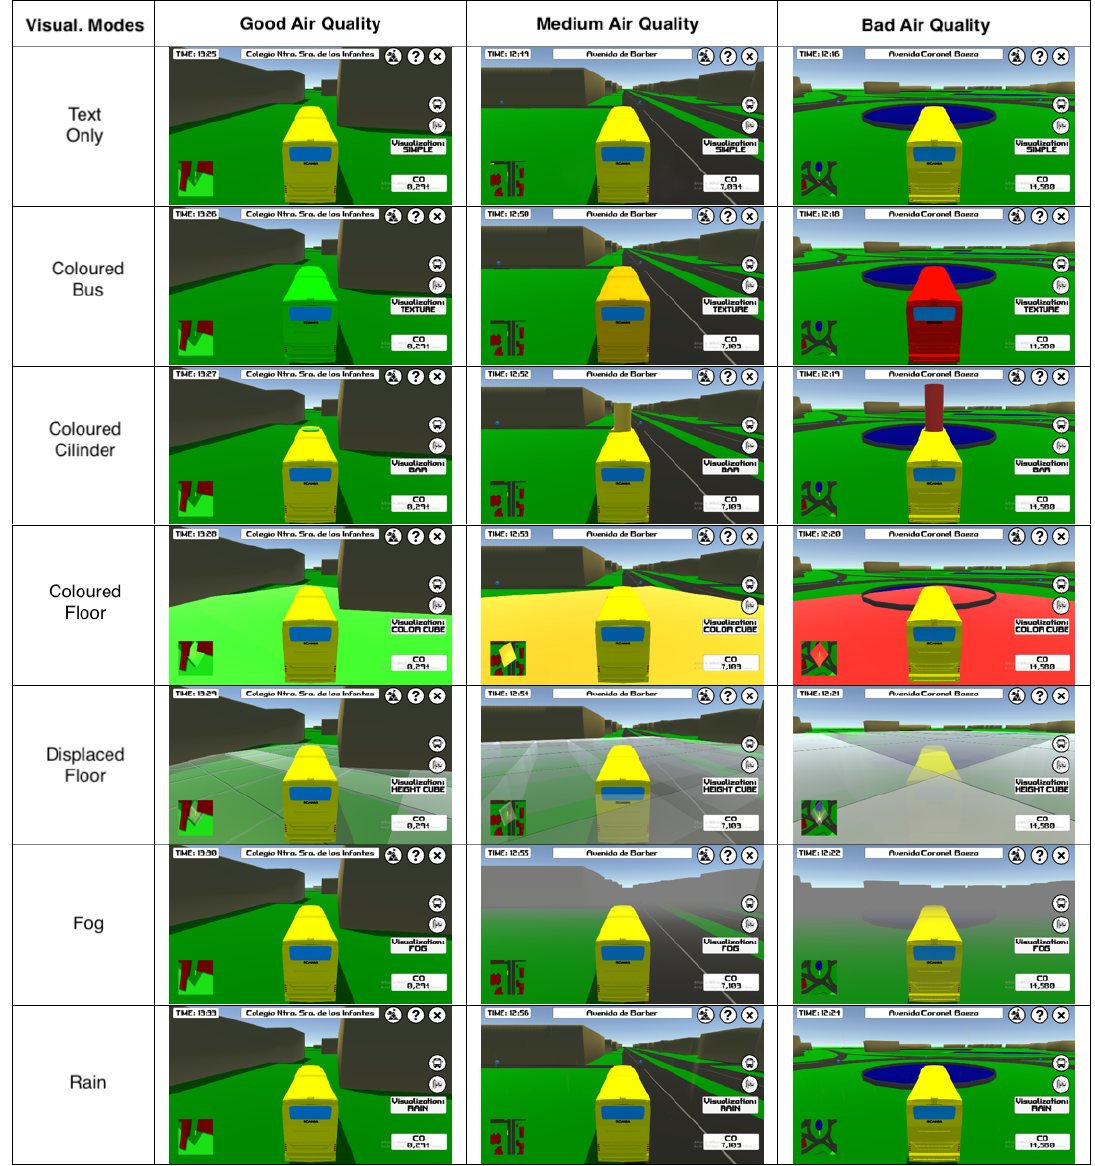
Figure 4. Pollution visual representations. Examples for good, medium, and poor air quality